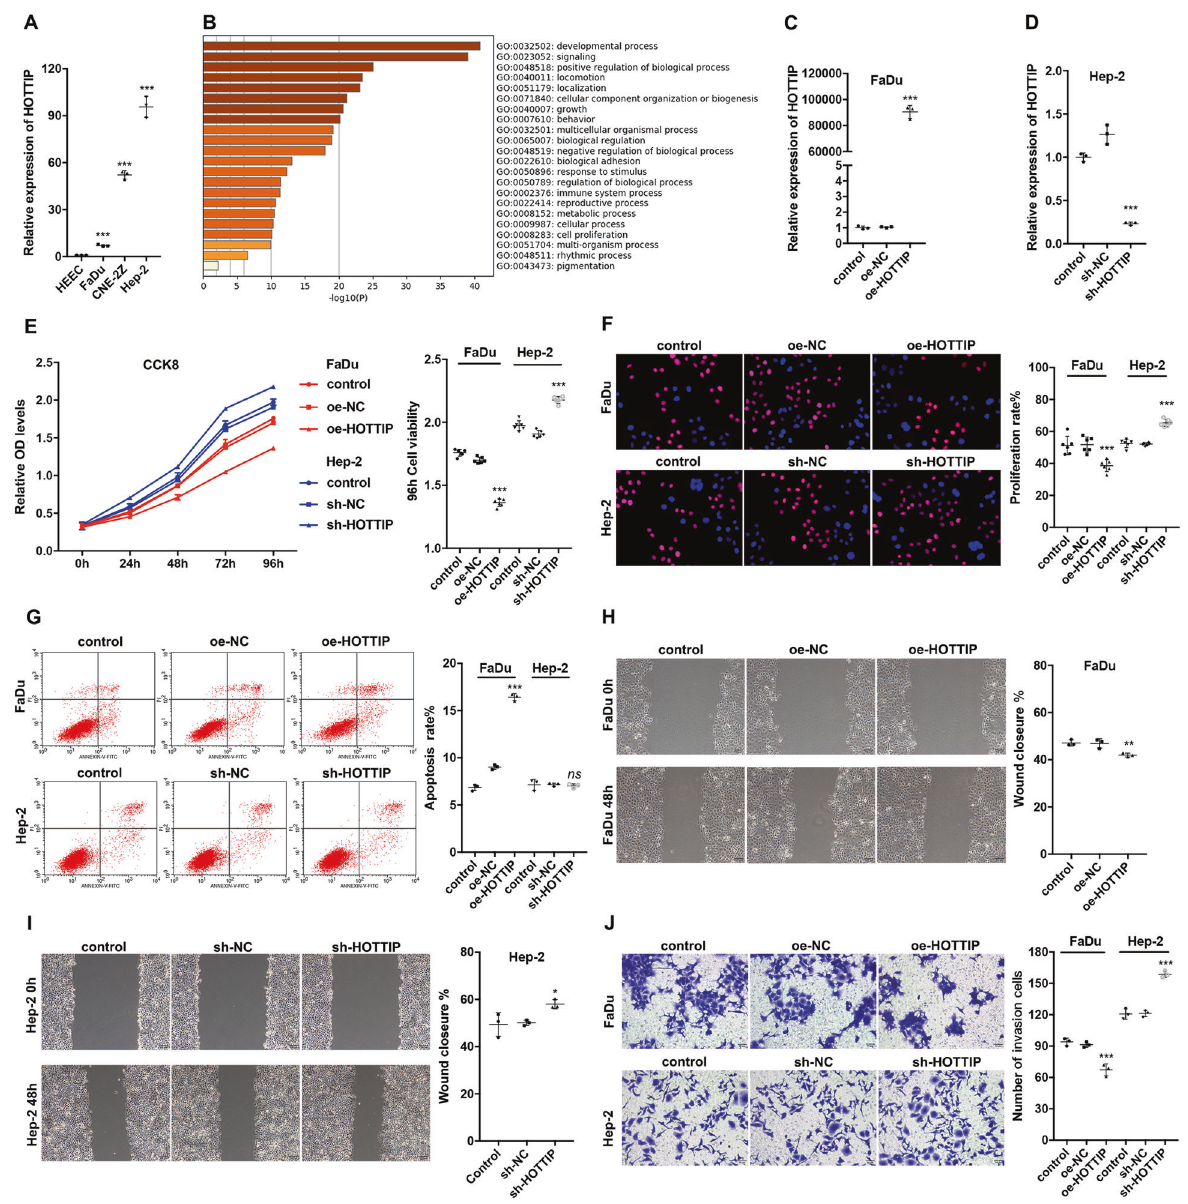
Fig. 3 HOTTIP suppresses HNSCC progression in vitro. A RT-qPCR detected the relative expression of HOTTIP in three HNSCC cell lines compared to those in HEEC cells ( n = 3). B Top 22 Gene Ontology processes following analysis of 3000 HOTTIP-associated genes. Ef fi ciency of HOTTIP expression in HOTTIP-overexpressed FaDu cells ( C ) and HOTTIP-knockdown Hep-2 cells ( D ) were con fi rmed using RT-qPCR ( n = 3). E CCK8 assay detected the cell viability after HOTTIP overexpression or knockdown. Overexpression of HOTTIP inhibited the cell viability of FaDu cells but knockdown of HOTTIP promoted the cell viability of Hep-2 cells at 24, 48, 72 and 96 h ( n = 6). F EdU assay evaluated the proliferation capacity of HOTTIP-overexpressed FaDu and HOTTIP-knockdown Hep-2 cells. Overexpression of HOTTIP inhibited the cell proliferation capacity of FaDu cells but knockdown of HOTTIP promoted that of Hep-2 cells ( n = 6). G Apoptosis assay. HOTTIP-overexpressed FaDu and HOTTIP-knockdown Hep-2 cells were incubated with FITC labeled Annexin V antibody and were then stained by PI. The apoptosis rates were determined by fl ow cytometry. Overexpression of HOTTIP induced apoptosis but knockdown of HOTTIP did not in fl uence apoptosis ( n = 3). Scratch test ( H, I ) and Transwell assay ( J ) examined the migration and invasion ability of HOTTIP-overexpressed FaDu and HOTTIP-knockdown Hep-2 cells. Overexpression of HOTTIP inhibited the cell migration and invasion ability of FaDu cells but knockdown of HOTTIP promoted that of Hep-2 cells ( n = 3). Data are presented as mean ± SD. Results were analyzed by One-way ANOVA with a post hoc test. Signi fi cance: * P < 0.05, ** P < 0.01, *** P < HOTTIP-knockdown xenografts, which was in line with the in vitro results (Fig. 6C, D). Interestingly, in another nude mice animal model, M1 exosomes reeducated TAMs into CD11b + iNOS + M1 macrophages (Fig. 6E), but they inhibited the polarization of CD11b + Arg1 + M2 ones (Fig. 6F). These data suggested that cancer cells expressing HOTTIP polarized TAMs into macrophages mixed